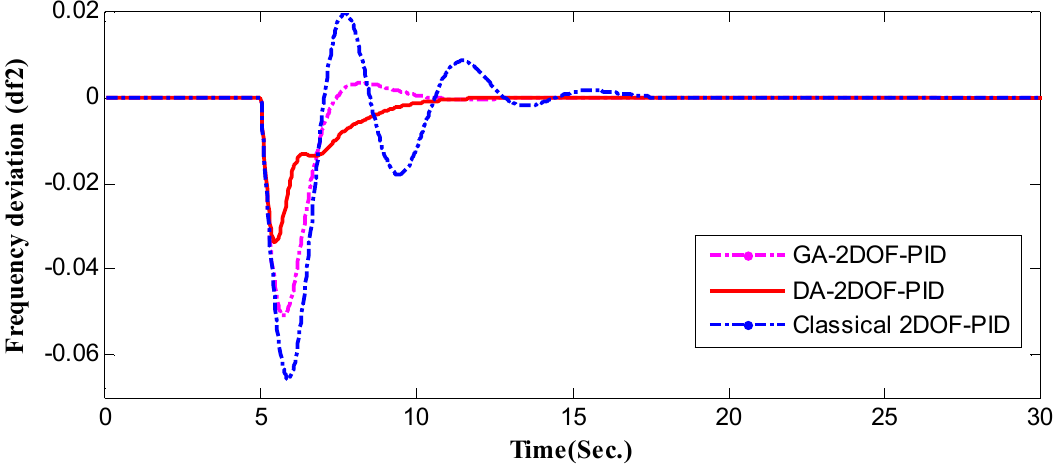
Figure 24. Δf (cid:2869) using GA-2DOF-PID, DA-2DOF-PID, and classical-2DOF-PID with IB-WGFF.